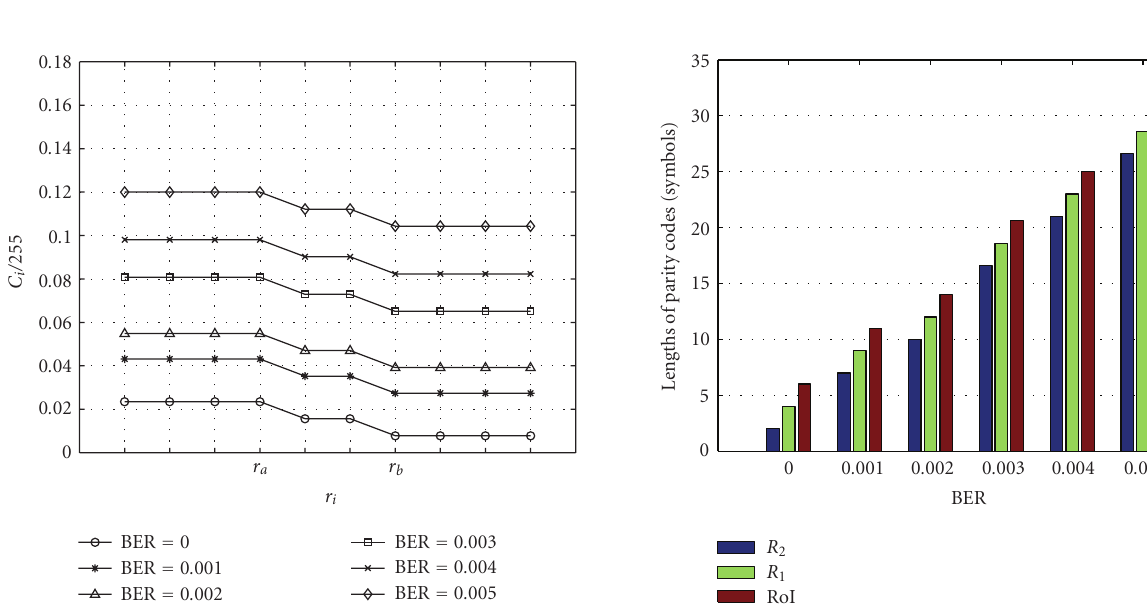
Figure 6: Lengths of the parity codes based on various channel noise